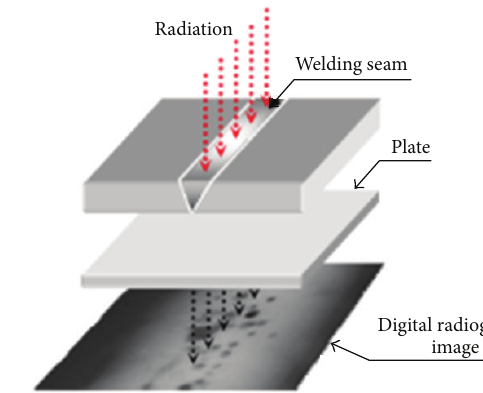
Figure 1: Weld radiography image acquisition [6].